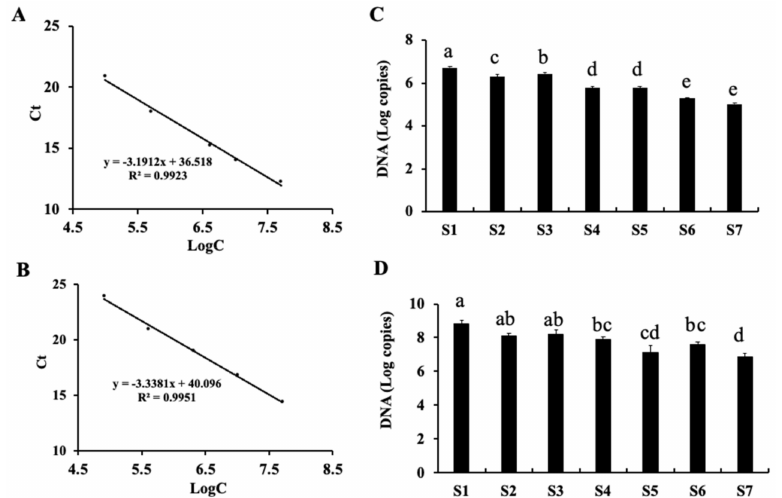
Figure 3. Quantitative changes of fungi and bacteria detected by qPCR during the processing and storage of Fu brick tea. ( A ) Standard curve of fungal plasmid; ( B ) Standard curve of bacterial plasmid; Quantitative changes of fungi ( C ) and bacteria ( D ) during processing and storage of Fu brick